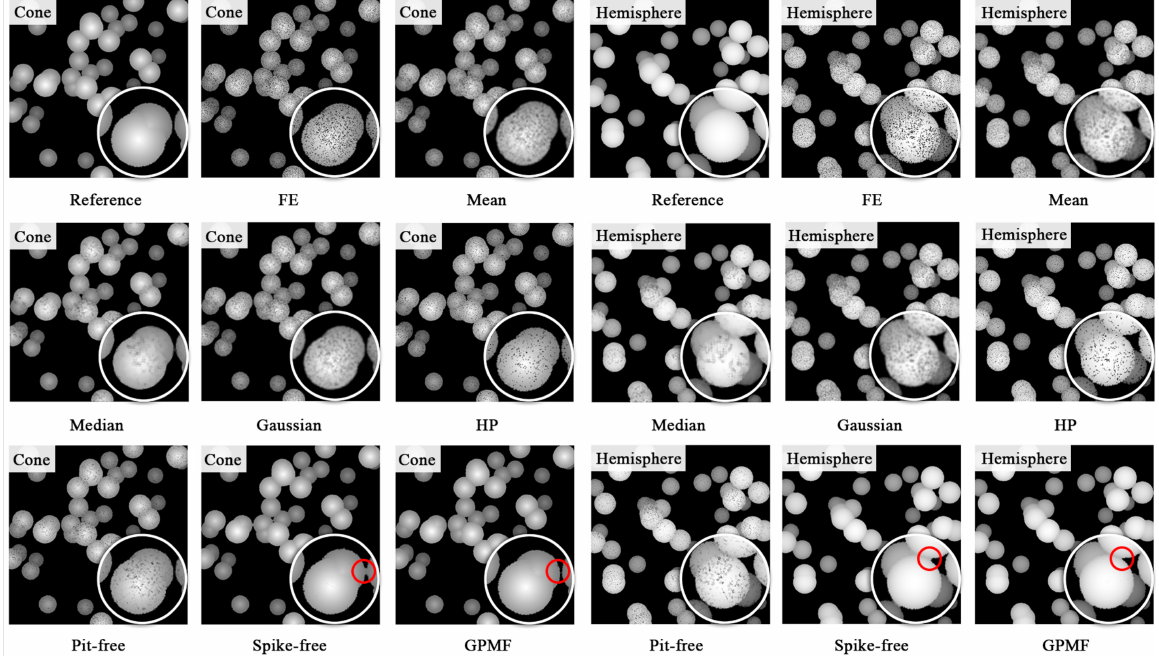
Figure 4. Comparison of CHMs generated by different methods based on simulated point clouds with 20%